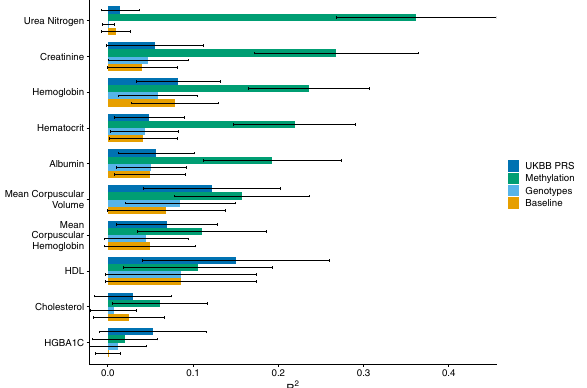
Fig. 4 Labs as imputed by methylation, genotypes, and an externally-trained polygenic risk score. The cross-validated R 2 between the true and imputed lab value on 541 unrelated patients of non-Hispanic-Latino white-identifying individuals using a base- line predictor as well as a baseline predictor with methylation, genotypes, and a PRS externally-trained from UKBiobank summary statistics. HDL corresponds to high-density lipoprotein cholesterol and HGBA1C to glycated hemoglobin. Error bars indicate 95% con fi dence